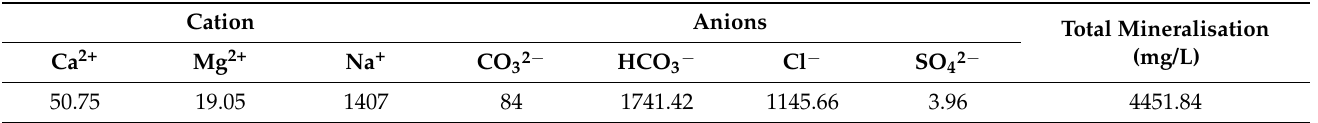
Table 12. Solvent water ion composition.